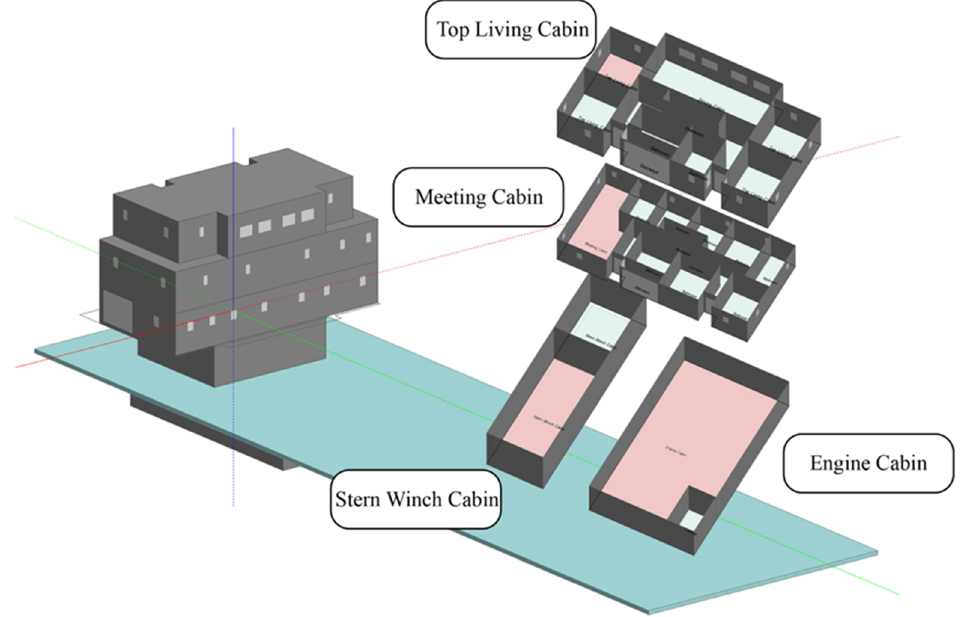
Figure 6. Simulation model of the ship.